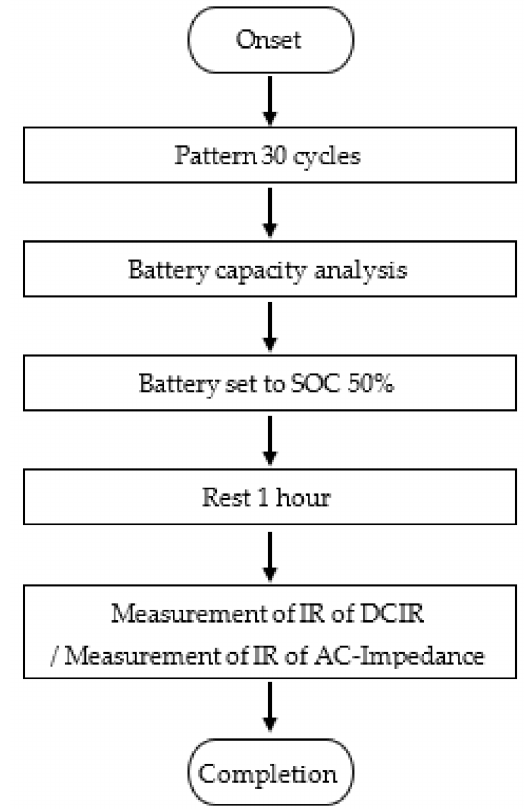
Figure 1. A flowchart of battery performance